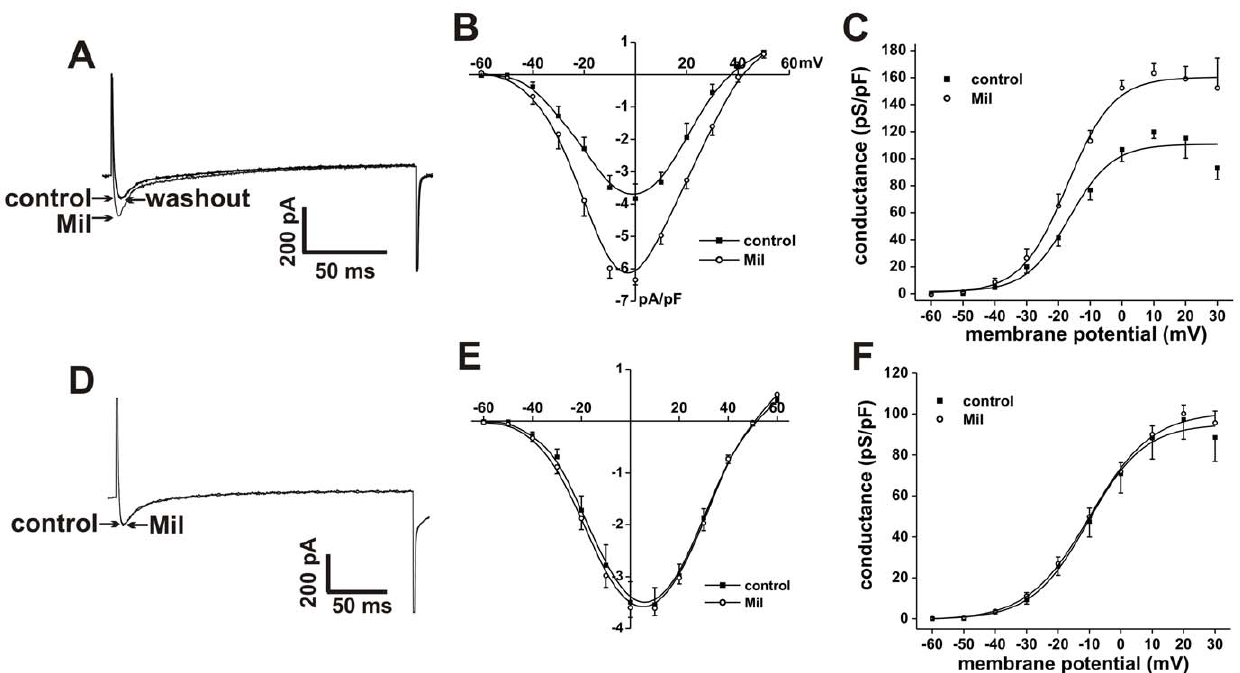
Figure 8. Effects of the PDE3 inhibitor milrinone on L-type Ca 2 + current in SAN and right atrial myocytes. A. Representative I Ca,L recordings in SAN myocytes in control conditions, in the presence of Mil (10 m M) and following Mil washout. B. Summary I–V relationships for the effects of Mil on SAN myocyte I Ca,L . C. Summary I Ca,L conductance density plots for the effects of Mil in SAN myocytes. D. Representative I Ca,L recordings in right atrial myocytes in control conditions, in the presence of Mil (10 m M), and following Mil washout. E. Summary I–V relationships for the effects of Mil on right atrial myocyte I Ca,L . F. Summary I Ca,L conductance density plots for the effects of Mil in right atrial myocytes. Summary data are means 6 SEM; n =6 SAN myocytes and 12 right atrial myocytes; * P , 0.05 vs. control by paired Student’s t -test.